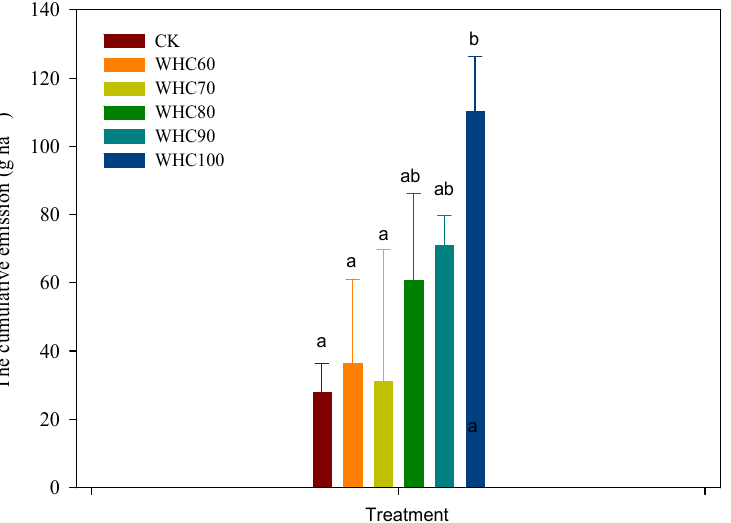
Figure 7. The cumulative emissions in CK and WHC60–100 from 15 December 2019 to 18 February 2020. Values with same superscript letters are of no significant difference ( p > 0.05), those with different letters are of significant or extreme difference ( p < 0.05). CK refers to the treatment without winter irrigation. WHC60, WHC70, WHC80, WHC90 and WHC100 refer to the treatments with winter irrigations where soil in 0–30 cm was irrigated to 60%, 70%, 80%, 90% and 100% of the soil water holding capacity on 15 December 2019,